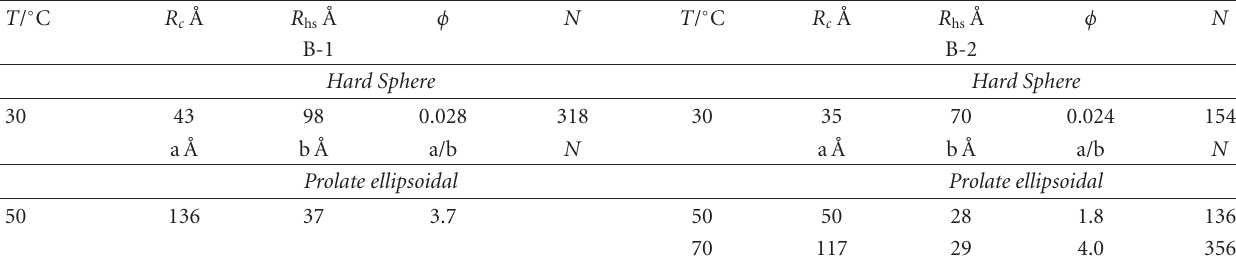
Table 2: Micellar parameters for 2% (w/v) copolymer solutions in D 2 O at di ff erent temperatures.